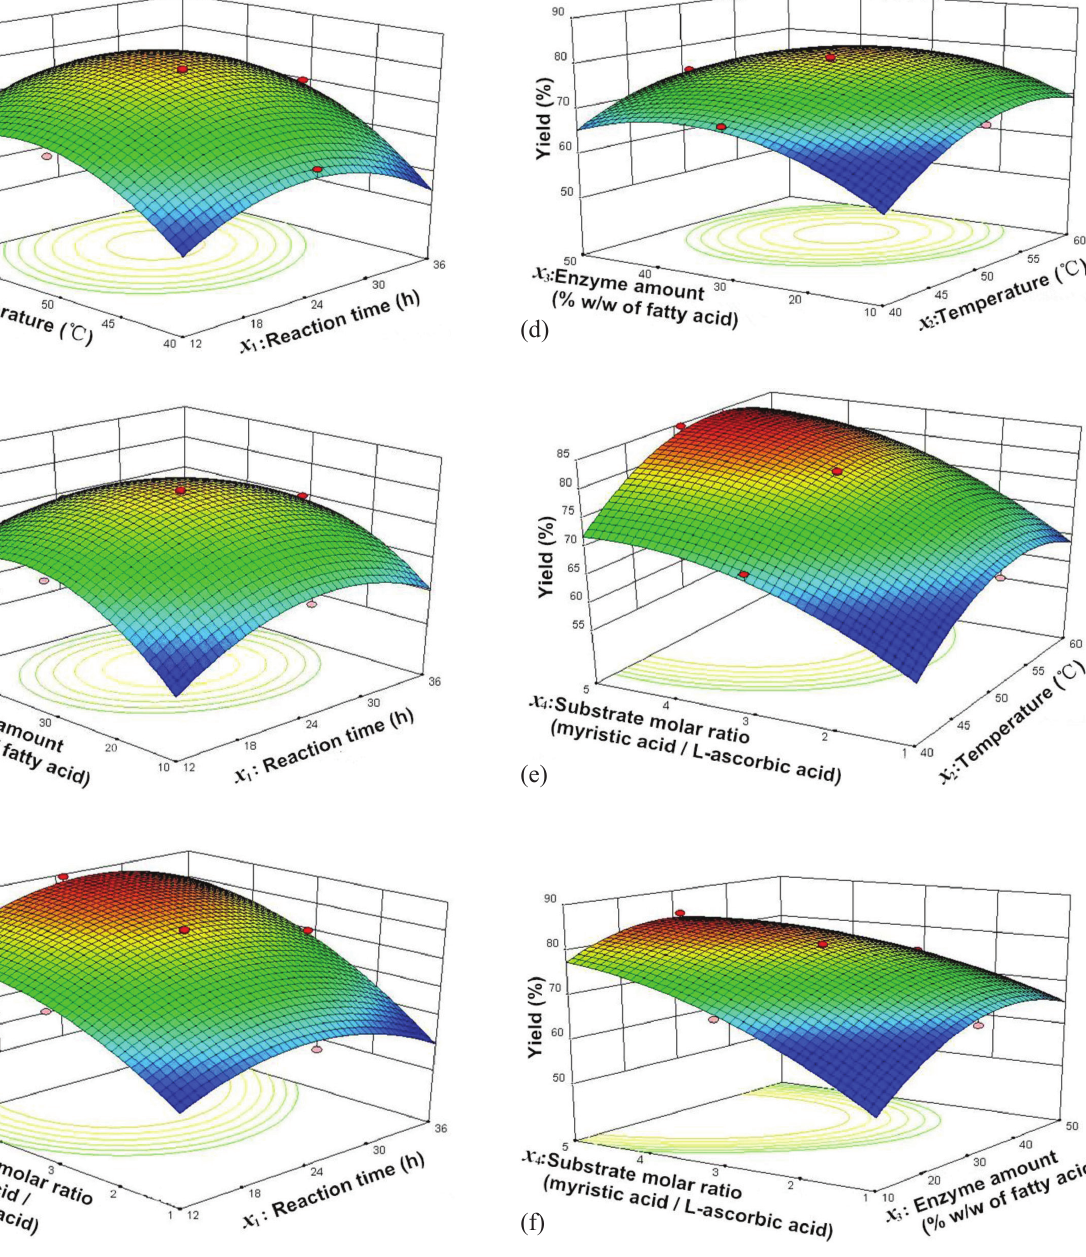
Fig. 1 – Response surface plot (3-D) showing the mutual effect of reaction time, temperature, enzyme amount, and molar ratio of myristic acid to ascorbic acid on the response (a) The molar ratio of myristic acid to ascorbic acid and the enzyme amount were fixed at 3 and 30 %, respectively (b) The molar ratio of myristic acid to ascorbic acid and the temperature were fixed at 3 and 50 °c, re - spectively (c) The temperature and the enzyme amount were fixed at 50 °c and 30 %, respectively (d) The molar ratio of myristic acid to ascorbic acid and the reaction time were fixed at 3 and 24 h, respectively (e) The reaction time and the enzyme amount were fixed at 24 h and 30 %, respectively (f) The temperature and the reaction time were fixed at 50 °c and 24 h,